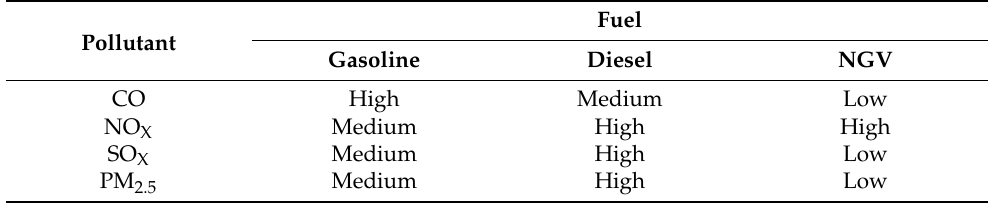
Table 2. Fuel type vs. Pollutant